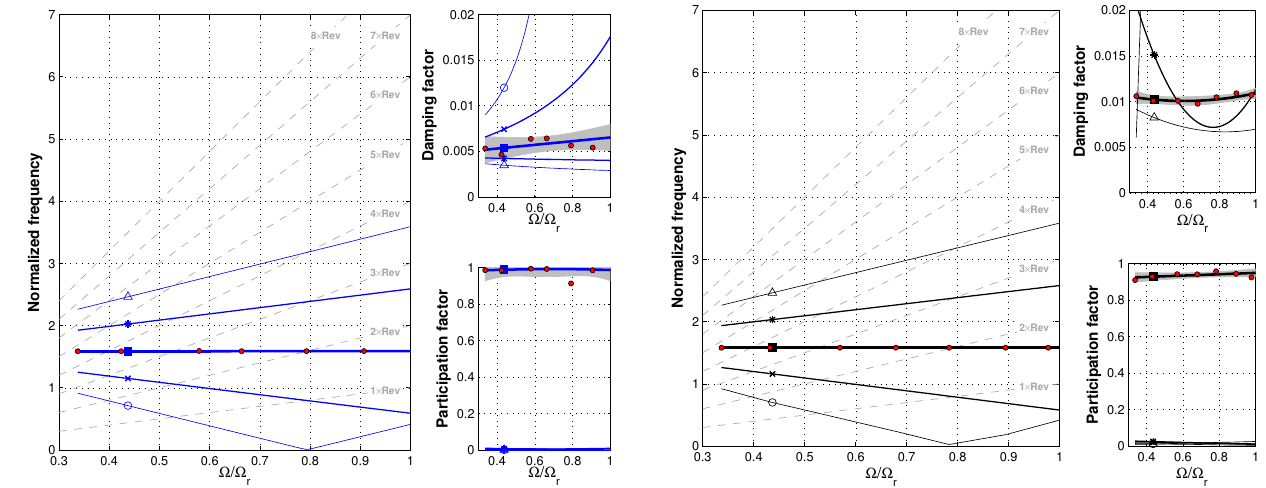
Figure 8. Periodic Campbell diagram for the tower side–side mode obtained from PARMAX (left) and POMA (right) identifications.